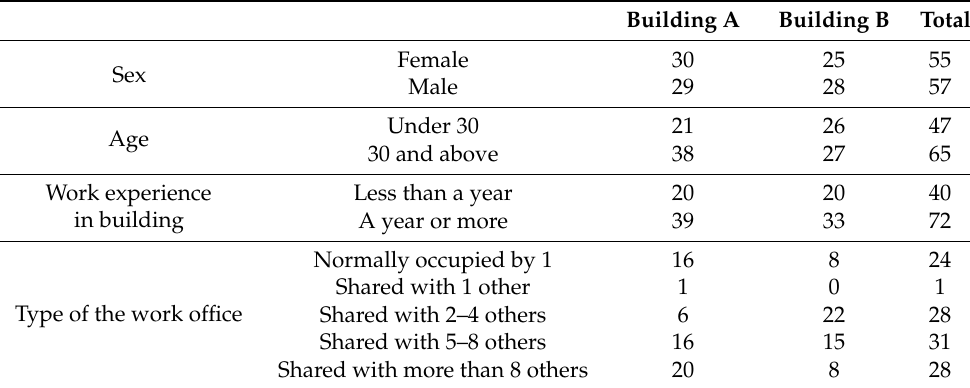
Table 4. Background and demographic information of valid